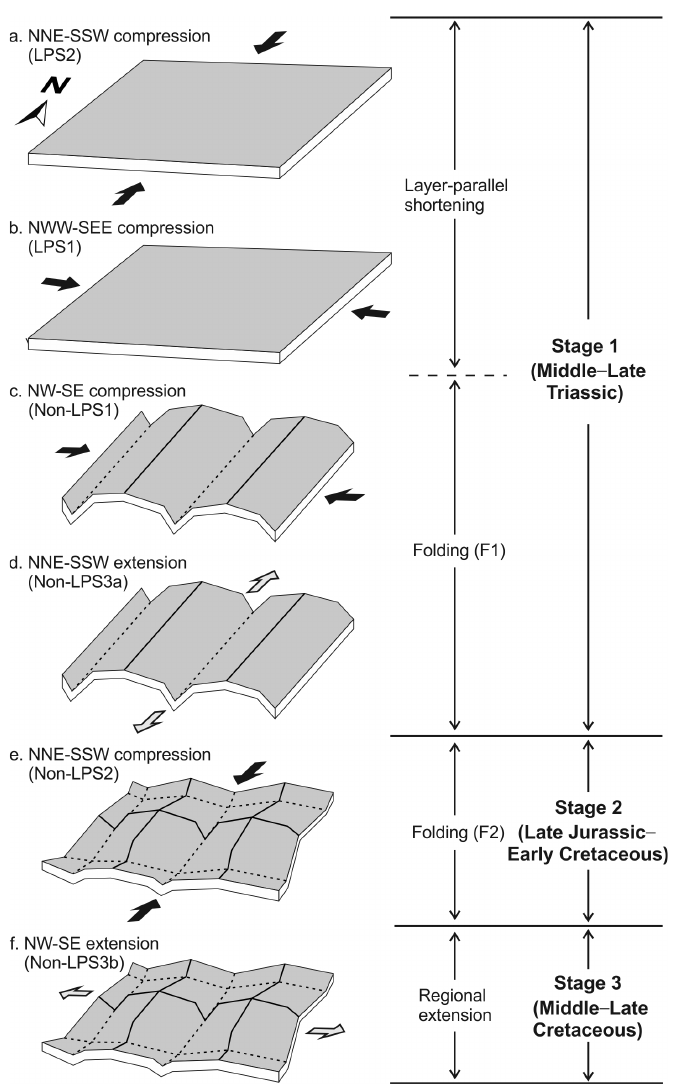
Figure 14. Three-stage scenario of Mesozoic structural deformation in the study area.